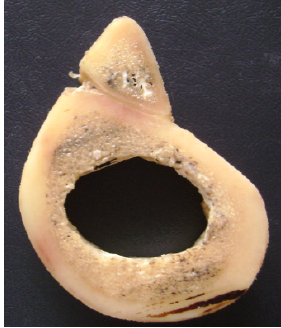
Figure 2. Transversal section of a bovine femur. Cortical and cancellous bone can be easily distinguished.